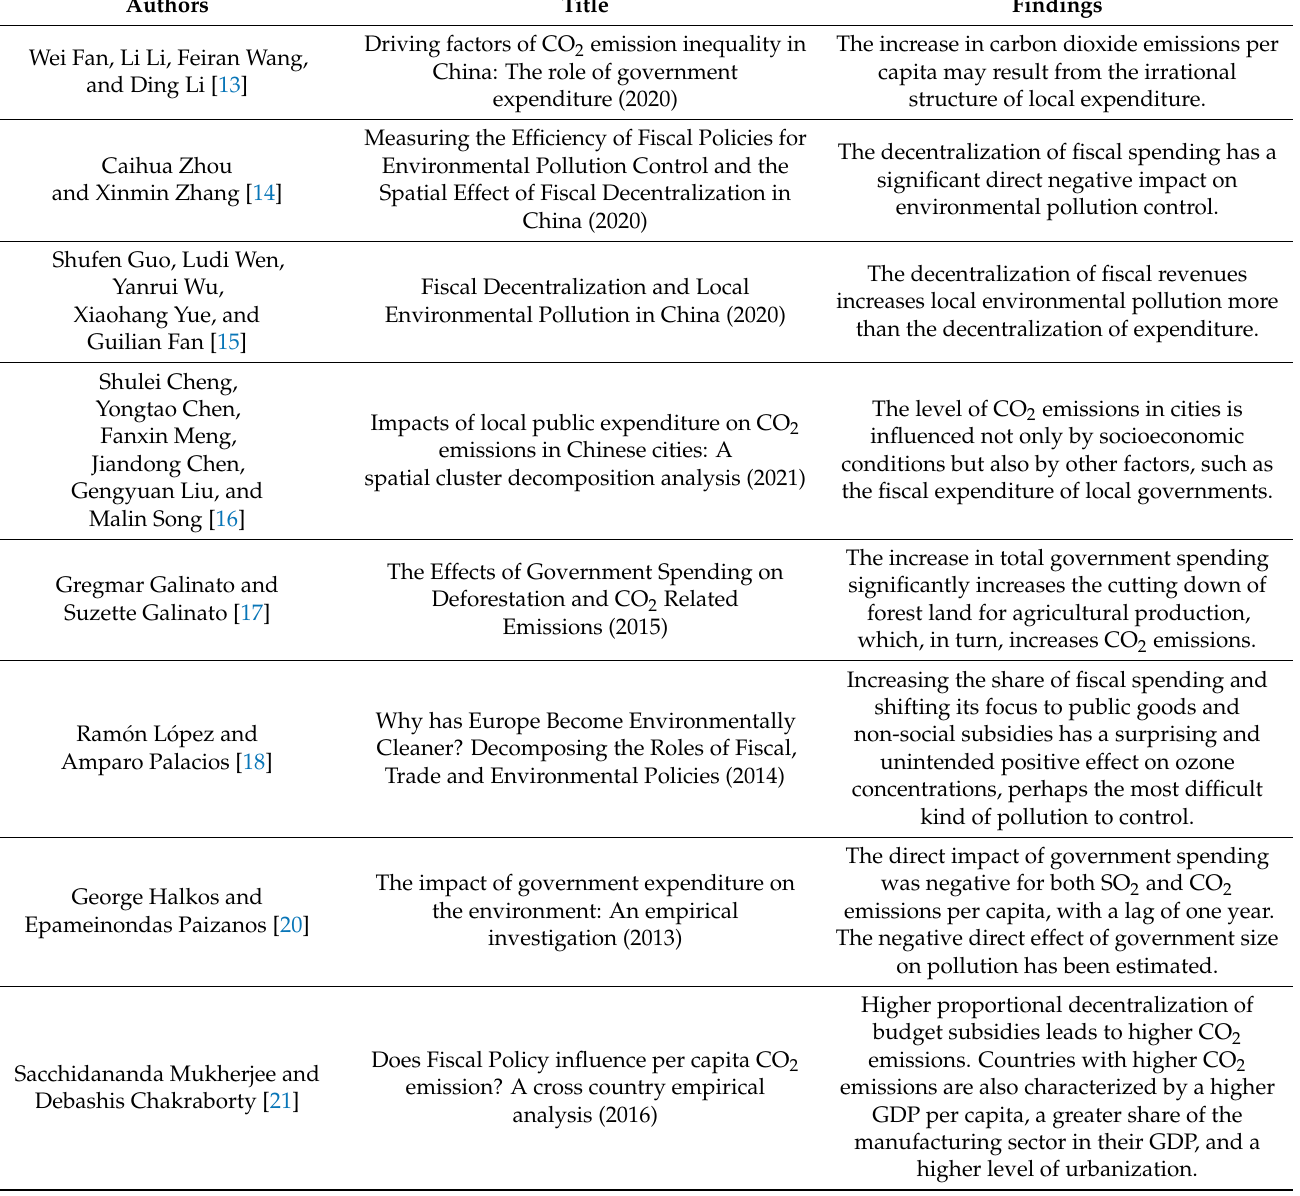
Table 1. Review of research on the impact of economic factors (especially fiscal instruments) on the level of CO 2